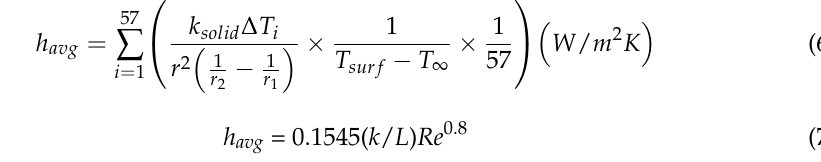
Figure 11. Correlation of average heat transfer coefficient with the Reynolds number.